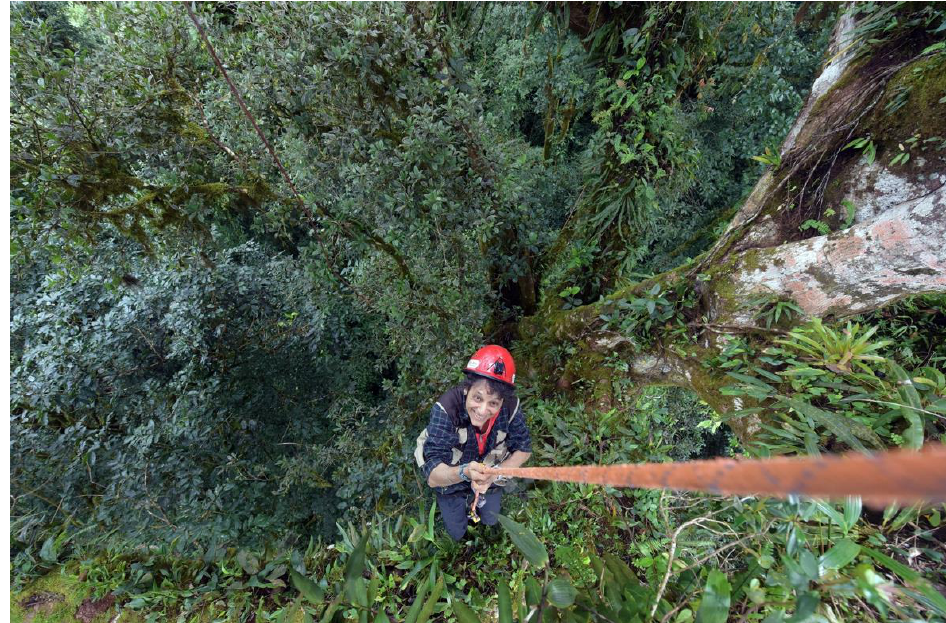
Figure 3. Nalini Nadkarni ascending a tall rainforest tree in Monteverde, Costa Rica, for her canopy research. Photo credit: Sybil Gotsch .